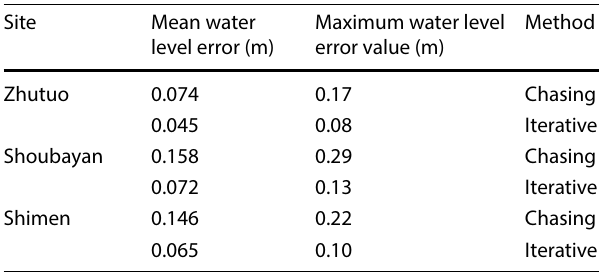
Table 1 Verification of the water level in Zhutuo Site Mean water level error